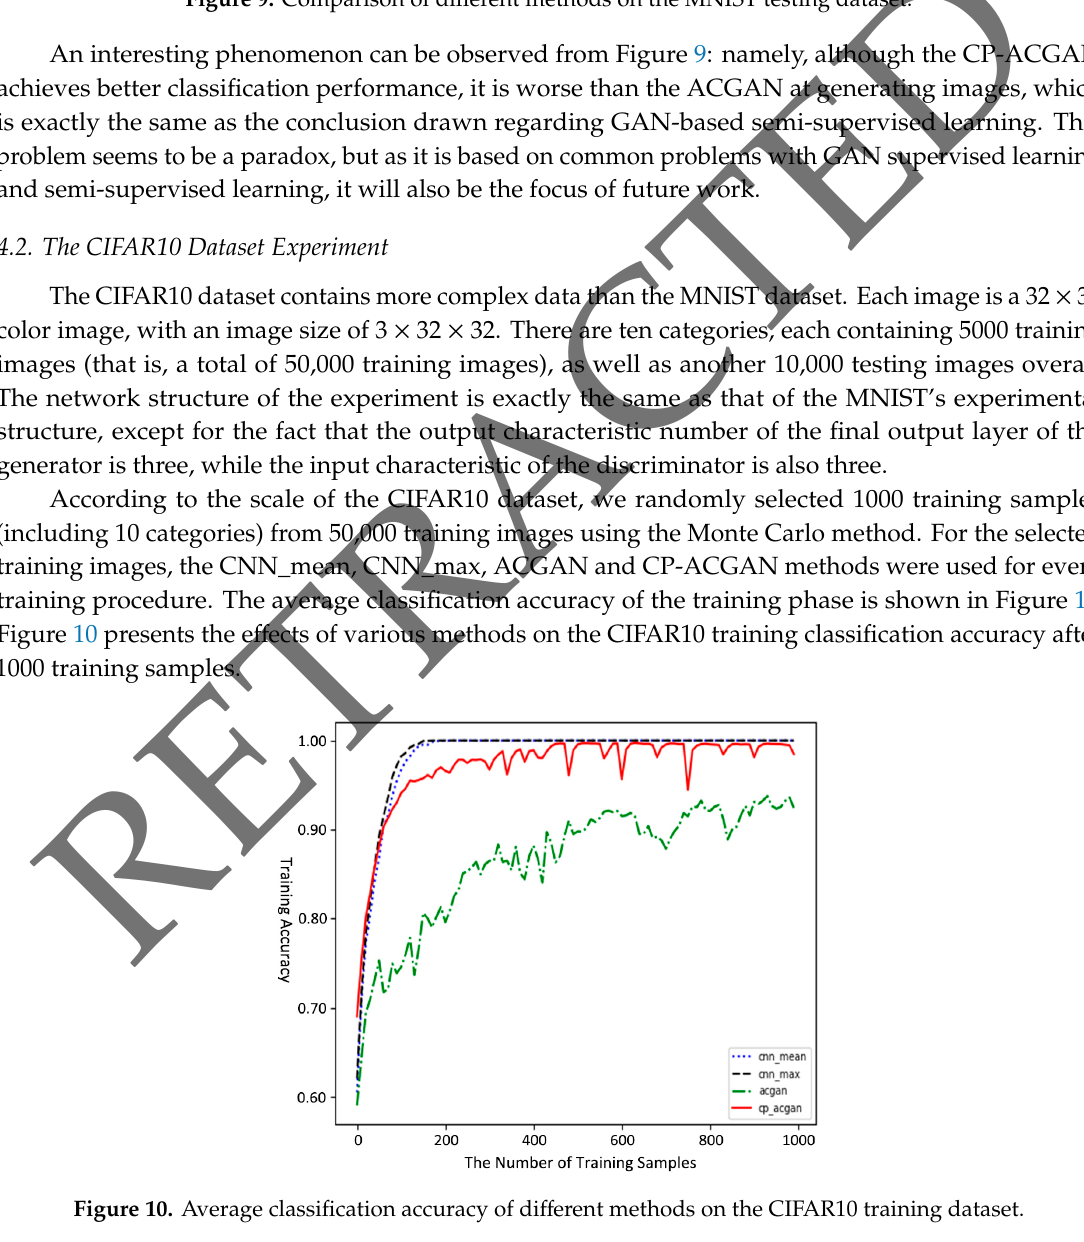
Figure 9. Comparison of different methods on the MNIST testing dataset.